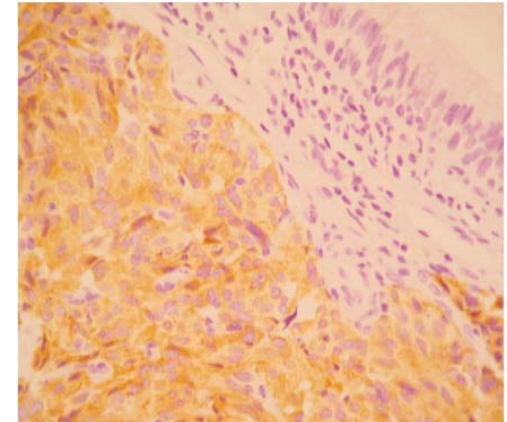
Figure 4 - Synaptophysin expression